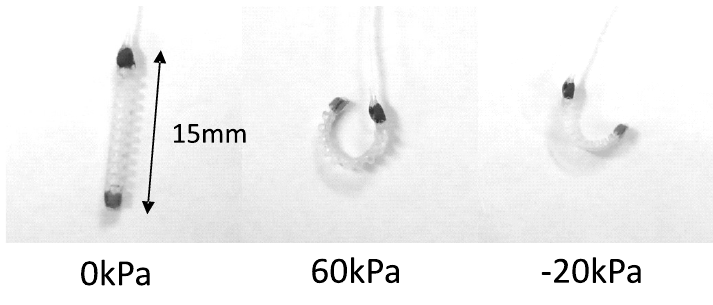
Figure 2. The states of movement of the